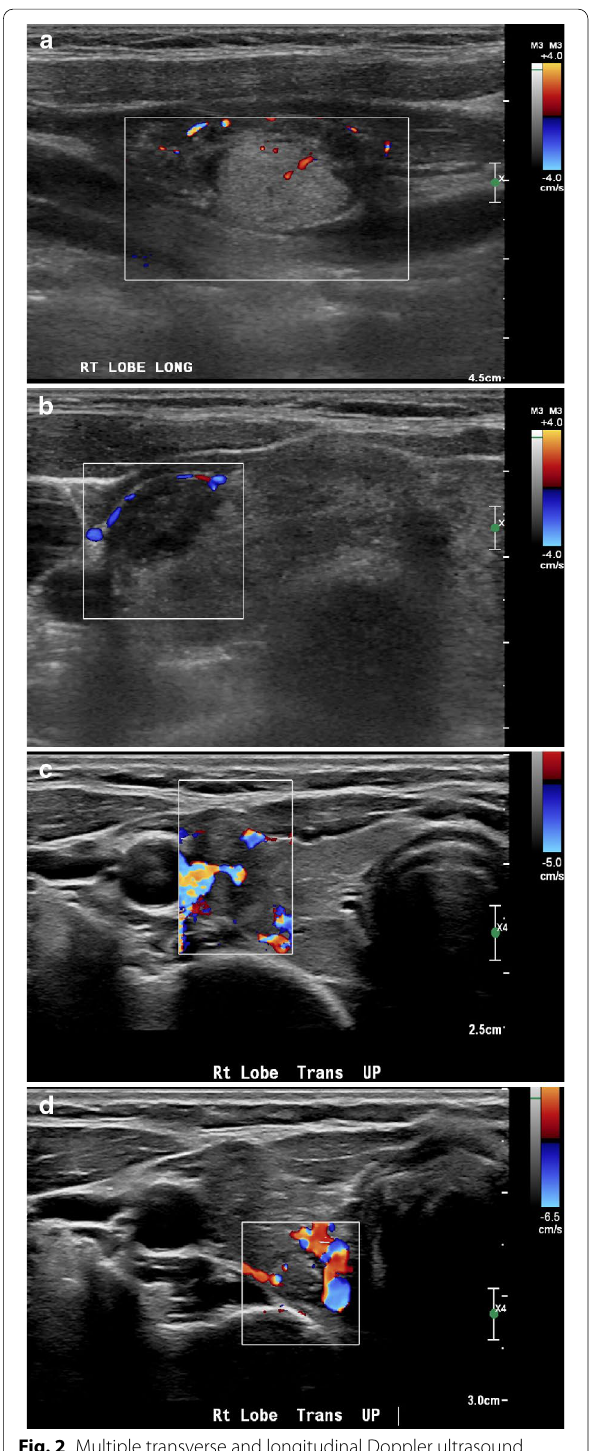
Fig. 2 Multiple transverse and longitudinal Doppler ultrasound images performed by linear probe showing: a A hyperechoic nodule with internal vascularity seen within. b A hypoechoic nodule with peripheral vascularity seen surrounding it. c A non-homogenous isoechoic nodule with mixed peripheral and central vascularity. d A hyperechoic nodule with mixed peripheral and internal vascularity